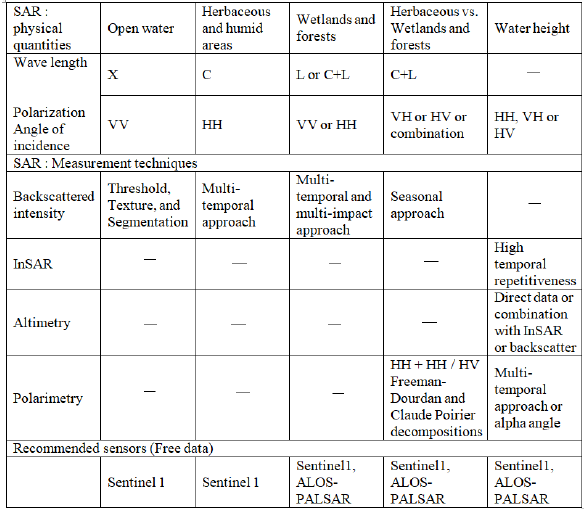
Table 1 . Recommendations for the use of SAR for